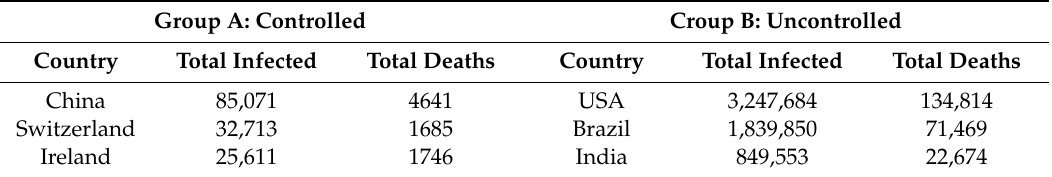
Table 2. Covid-19 infection cases and deaths reported.